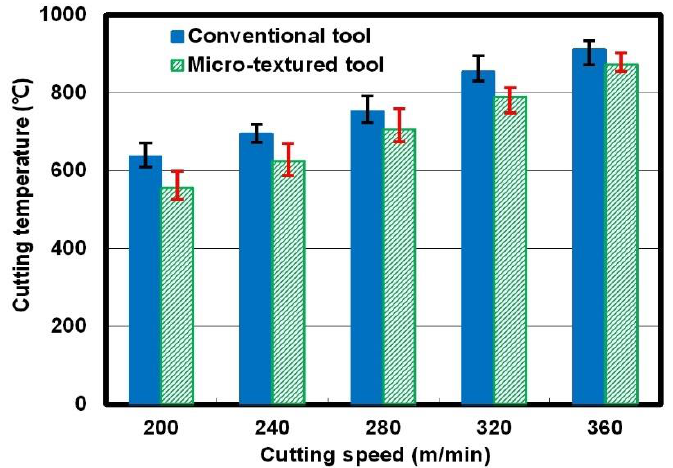
Figure 3. Cutting temperatures of the micro-textured tool and the conventional tool at different cutting speeds.